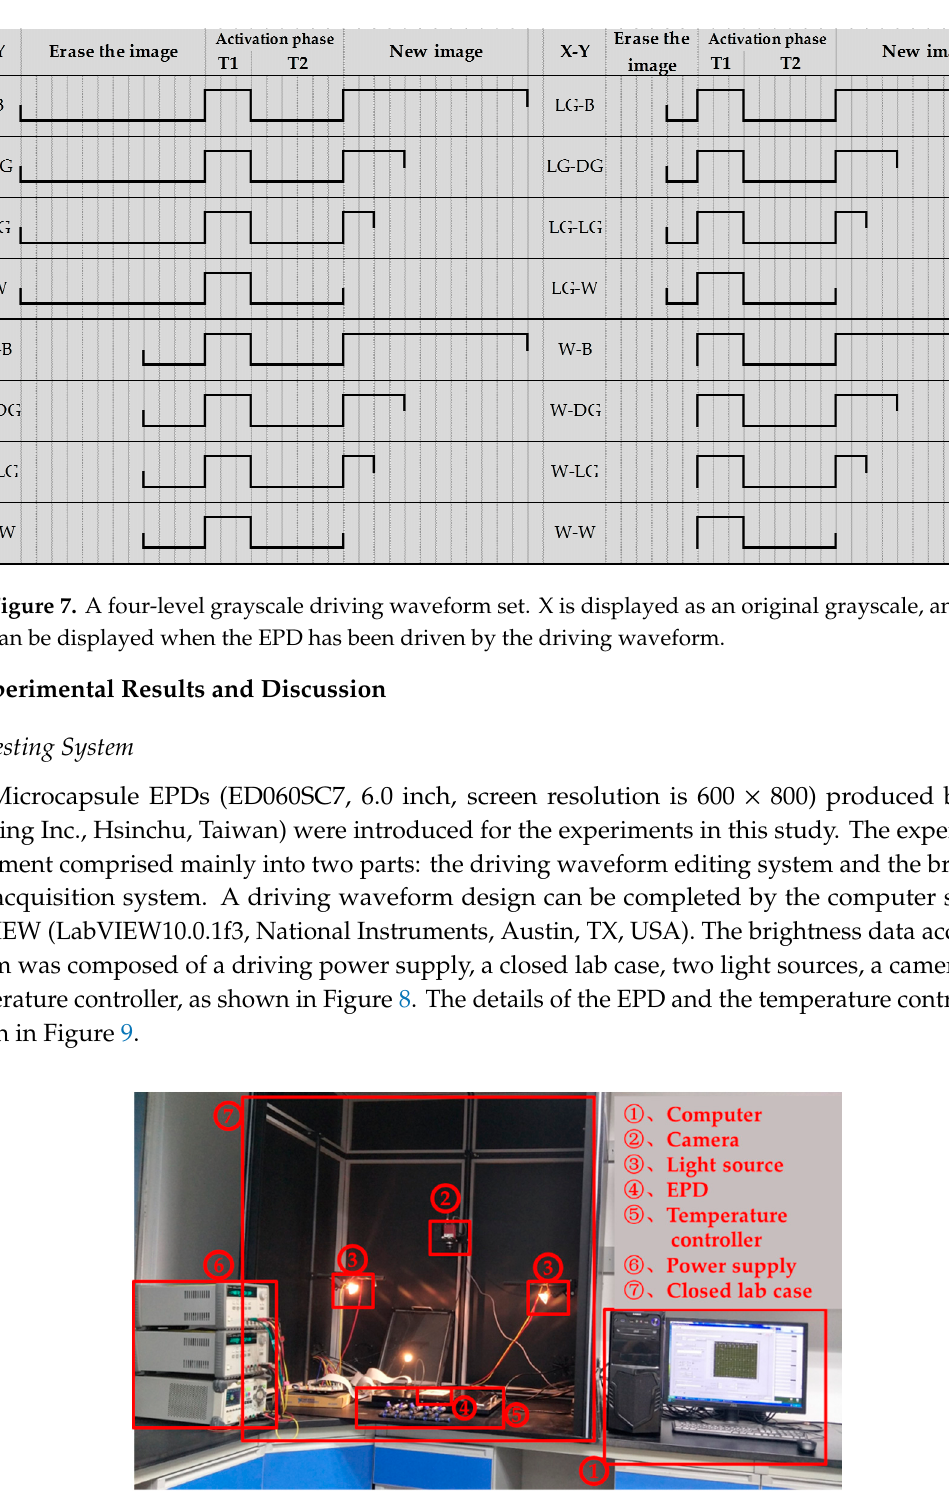
Figure 8. Optical testing device for EPDs. Camera was ADIMEC-1600m. Light sources were Brilliantline 12V 20W 36D Halogen. Temperature controller was Julabo FP25-ME. The power supply was an Agilent 3161A three-way output power supply.